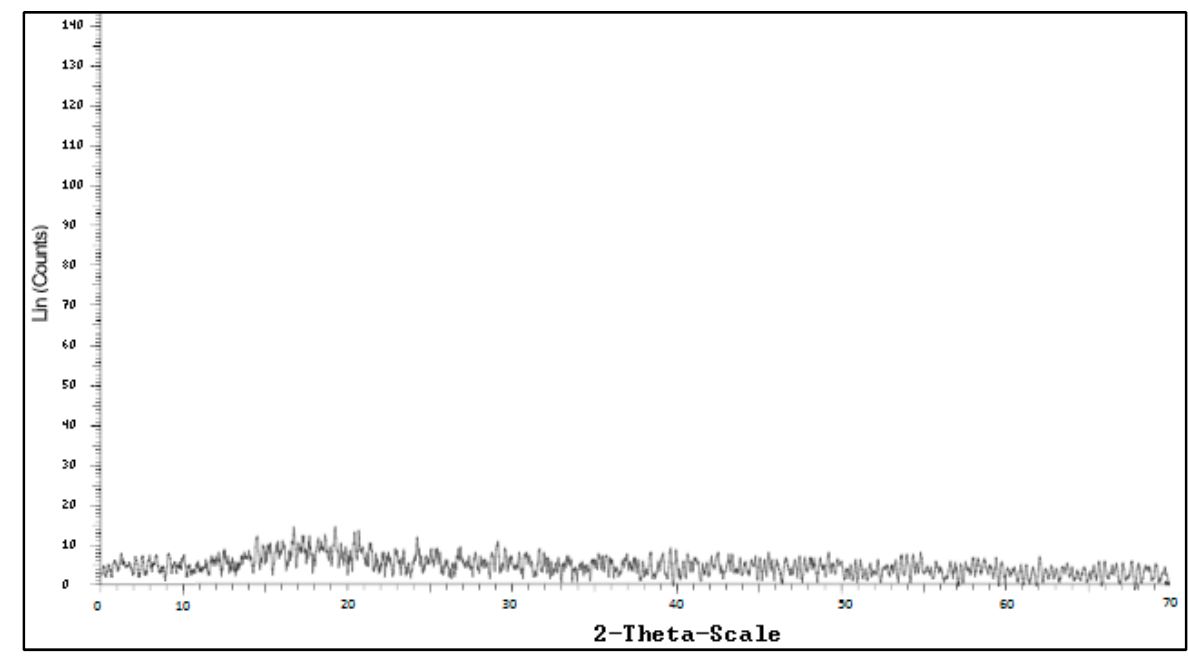
9 of 16 Figure 5. GPC spectroscopy of antioxidant carrageenan. X-ray diffraction (XRD) is the sole laboratory technique that equips structural in-